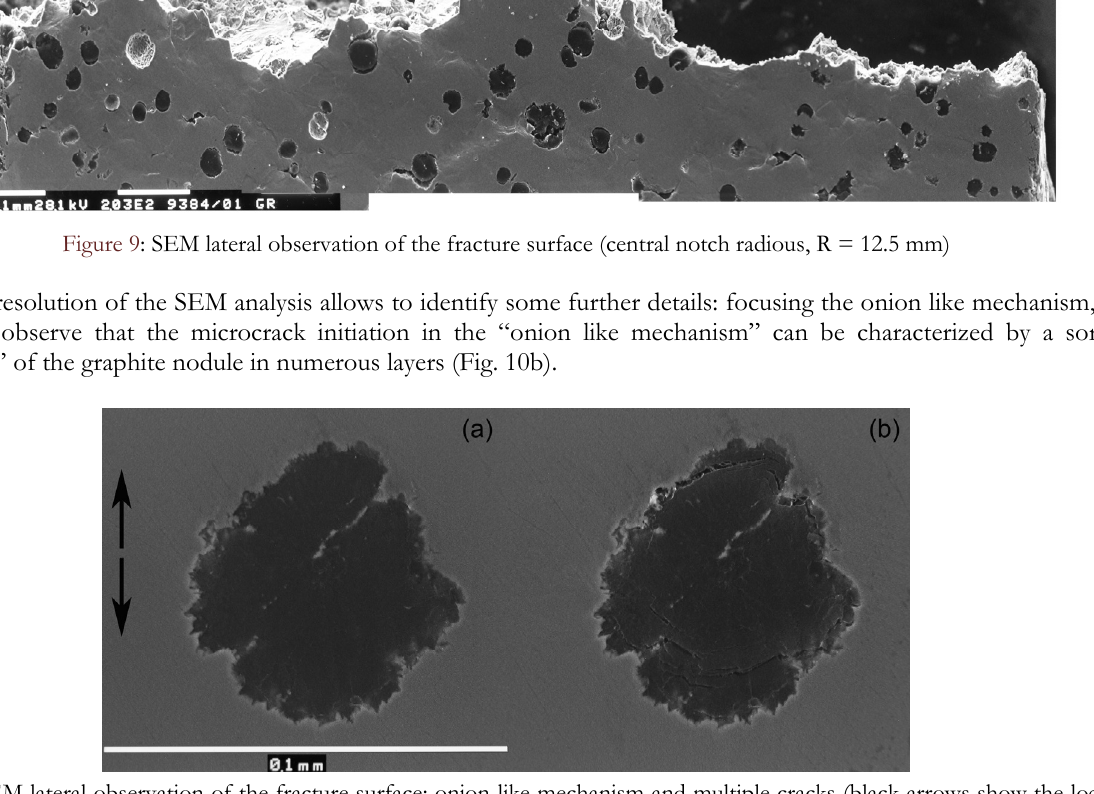
Figure 10: SEM lateral observation of the fracture surface: onion-like mechanism and multiple cracks (black arrows show the loading direction). (a) before the tensile test; (b) during the tensile